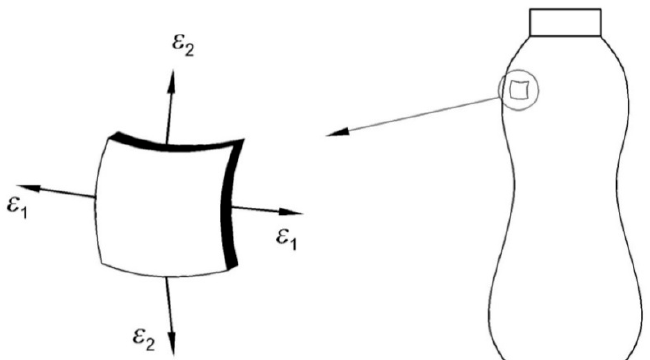
Figure 3. Schematic representation of principal strains in the walls of a sample axially symmetrical thin-walled vessel.